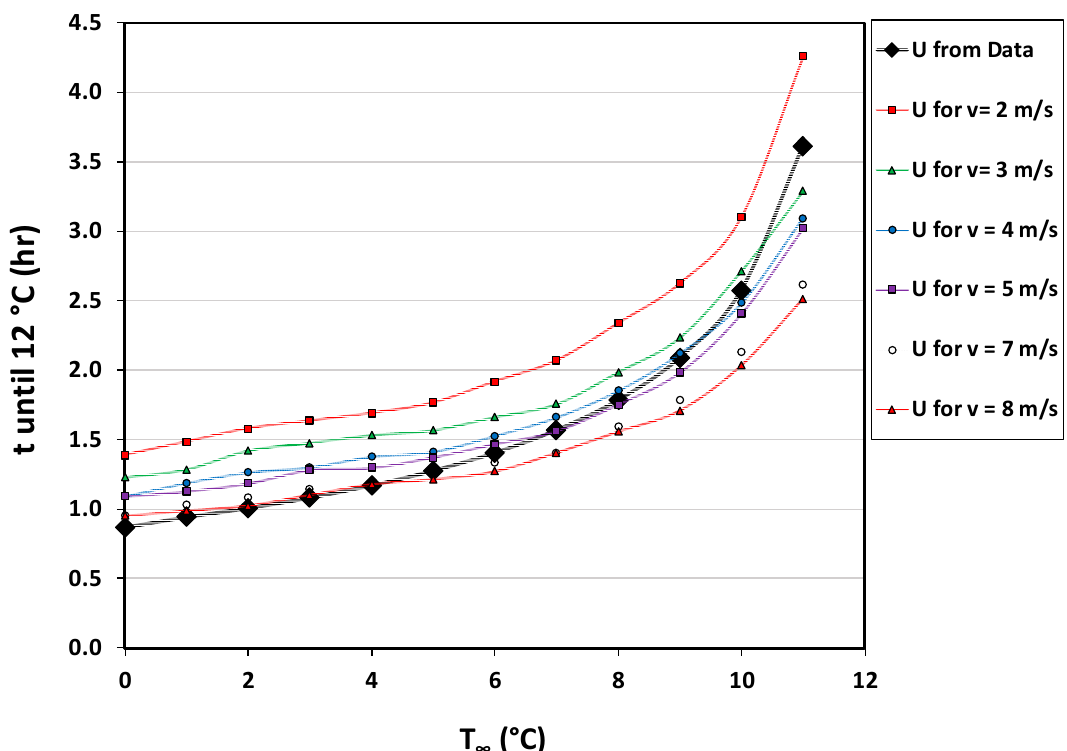
Figure 9. Reactor cooling times from both the tabulated and data-based heat transfer models. “U from Data” denotes cooling times based on the data-based model. All other cooling times are calculated from the tabulated model at different wind speeds.